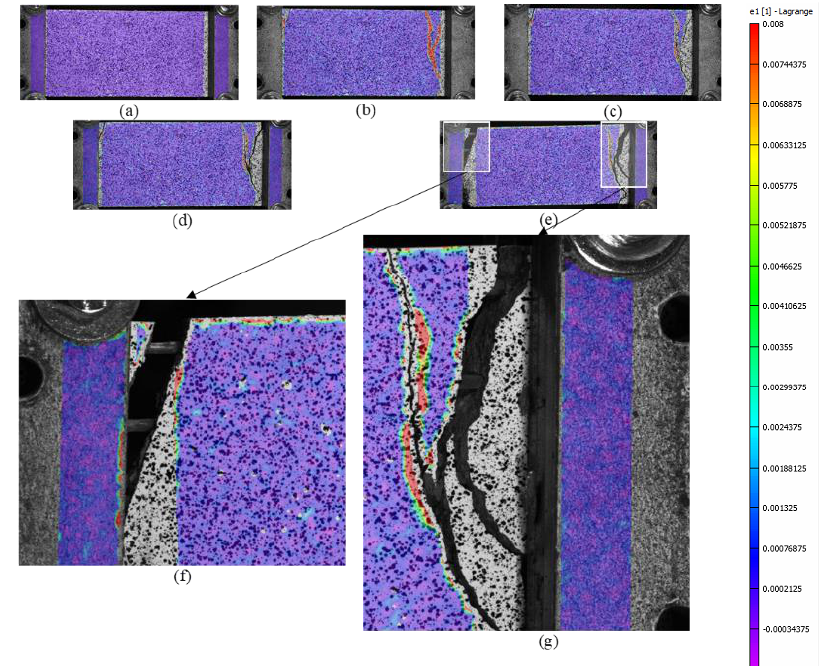
Figure 11. Pictures of specimen CP-1-A from DIC measurement during the various phases of the test: beginning of the test ( a ), appearance of the first crack ( b ), immediately before and after the first load drop ( c , d ), and when the test finished ( e ). Figures ( f , g ) are details of the cracks on the specimen. The color scale represents the grade of the major principal strains, from 0.008 units in red to − 0.0009 units in purple.